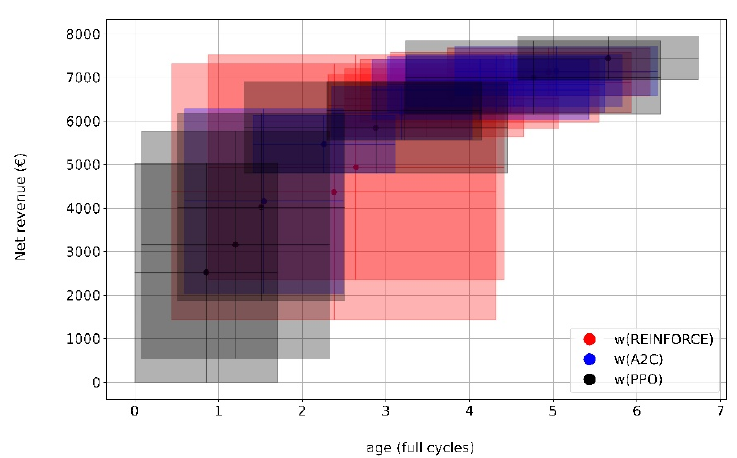
Figure 11. Scatter plot of net revenue and aging with standard deviation.